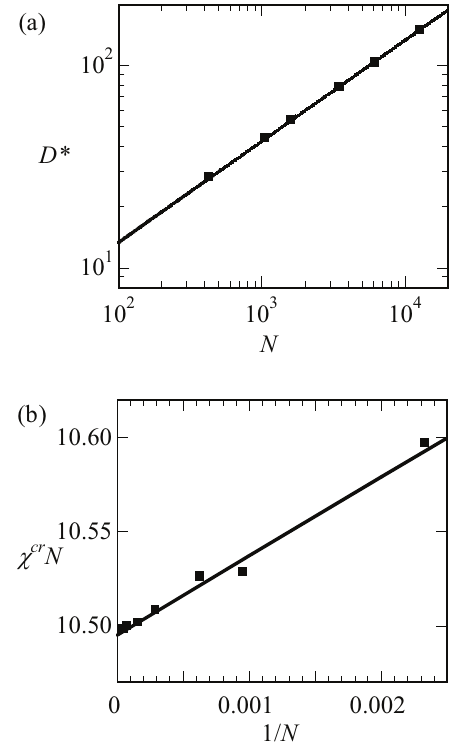
Figure 7. ( a ) The spacing at the critical point D ∗ of a lamellar phase at f = 0.5 as a function of the chain length N in double logarithmic coordinates. The fit of D ∗ = 4 ( b ) N -dependence on the critical χ N value. The function χ cr N = 10.495 the